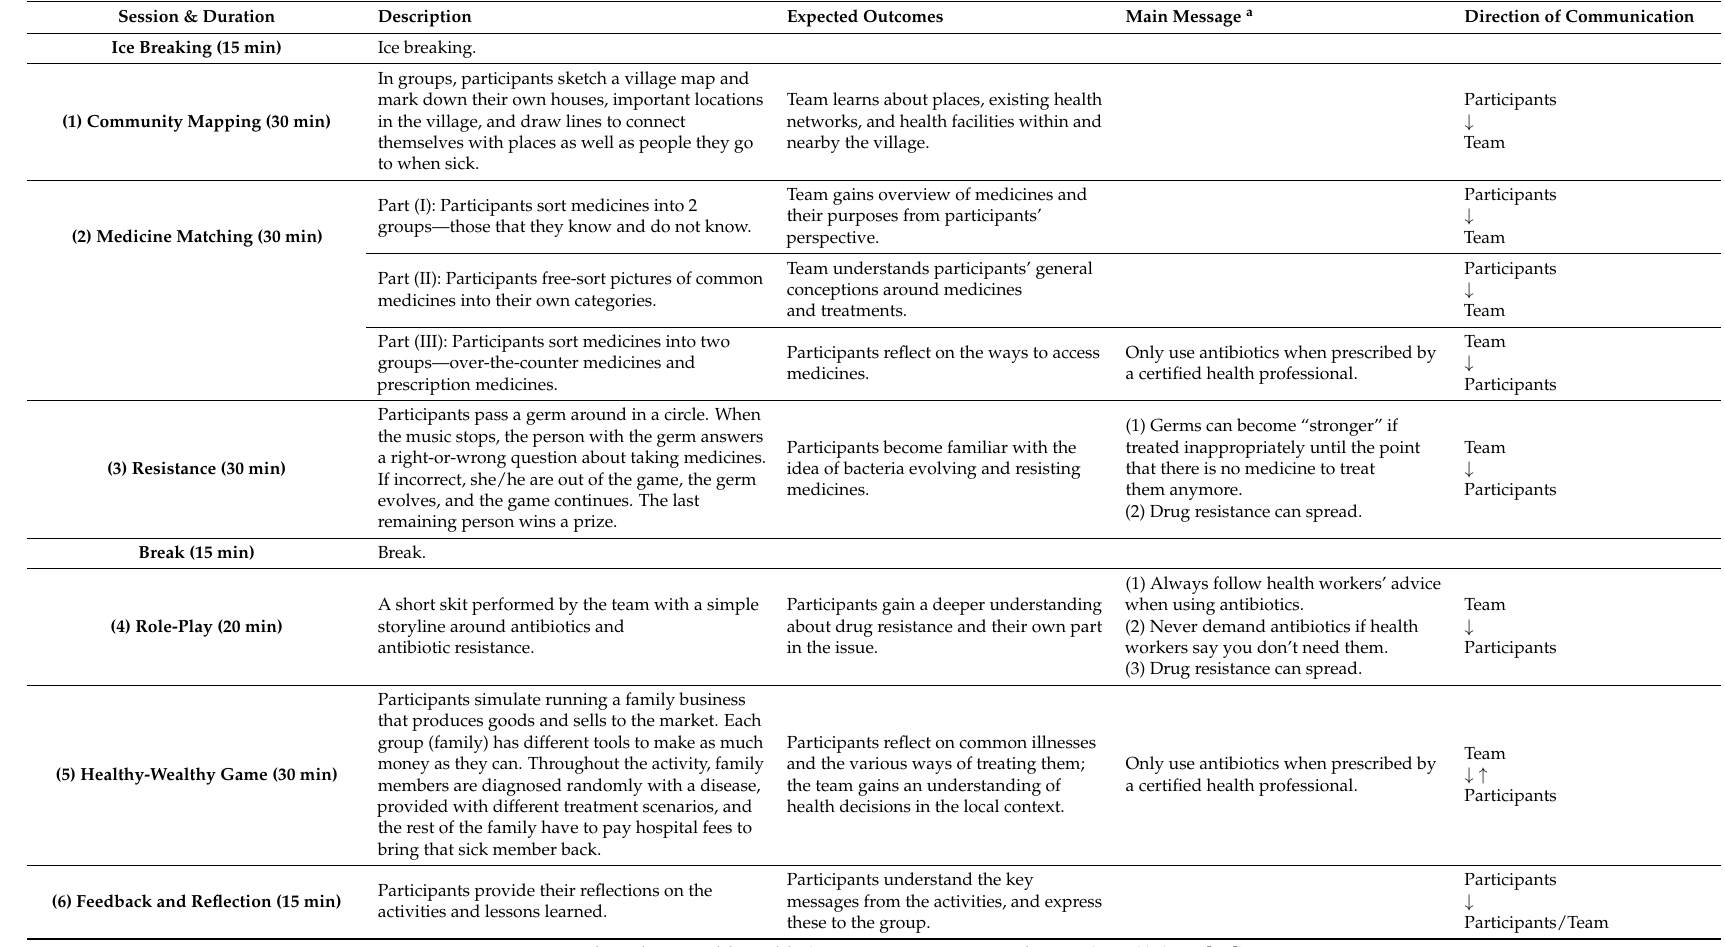
Table 2. Elements of the educational